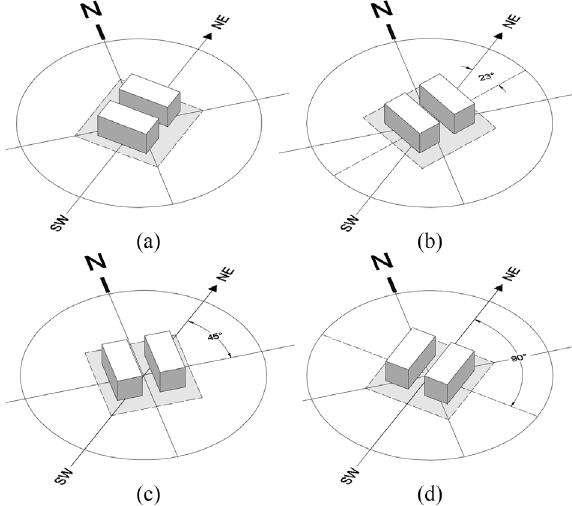
Figure 3. Example of canyon azimuthal directions in central Milan at 1-m spatial resolution, calculated using the Euclidean Direction tool in ArcMap 10.5